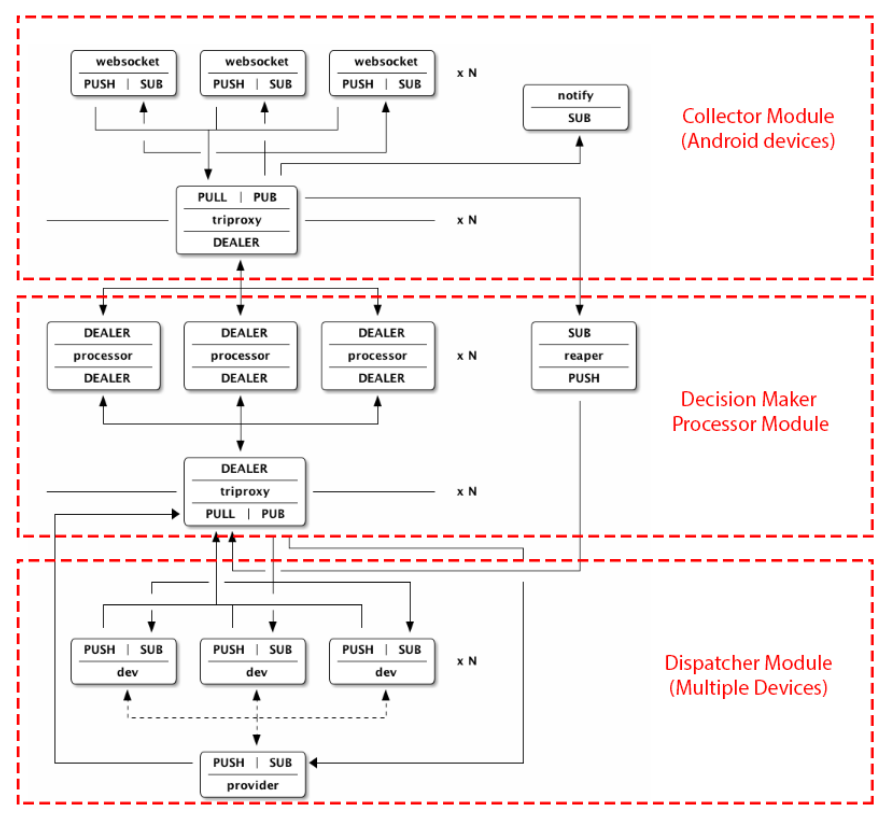
Figure 8. MQTT topology with the brokers and dealers.